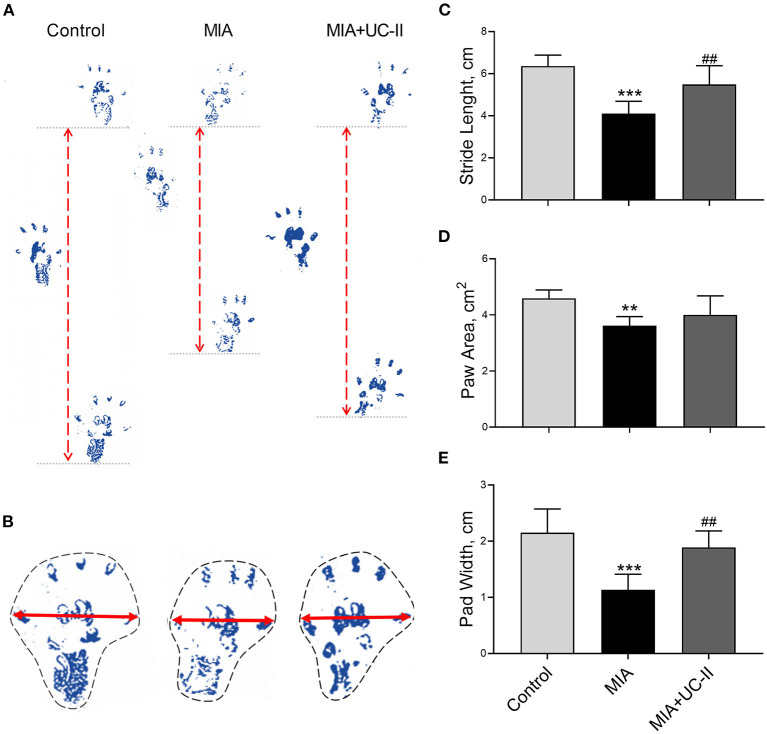
Effect undenatured type II collagen (UC-II) on stride length (C), paw area (D), and paw width (E) in monosodium iodoacetate (MIA) induced osteoarthritis rats (n = 7). Representative measures of stride length (A), paw area (B) and paw width (B) are shown. The bars represent the mean and standard deviation of data. ANOVA and Tukey's post-hoc test were used to compare the results among different treatment groups. Statistical significance between groups is shown by **P < 0.01, ***P < 0.001 compared to the control group and ## P < 0.01 compared to the MIA group.